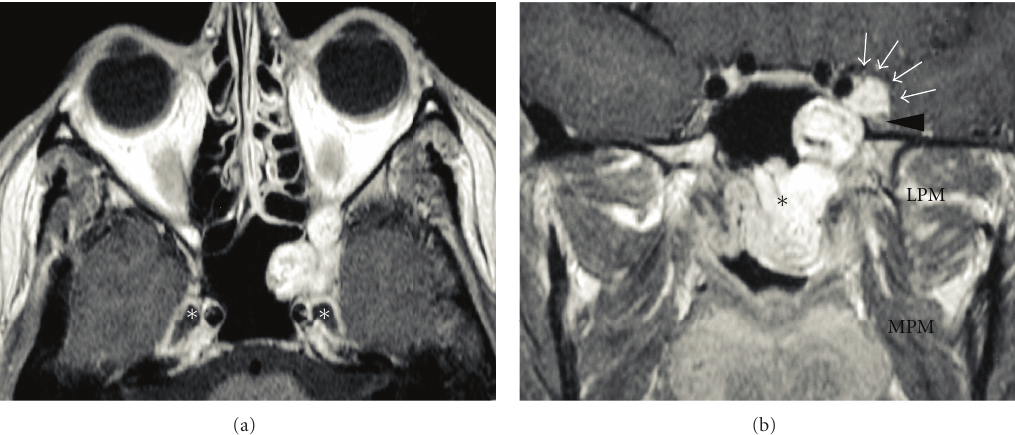
Figure 3: Axial (a) and coronal (b) contrast-enhanced MRI. JA with its epicenter into the root of the left pterygoid process. The nasopharyngeal component with submucosal spread is clearly evident (black asterisk). The lesion reaches the intracranial extradural compartment through the inferior and superior orbital fissures (white arrows), inferolaterally displacing the maxillary nerve (black arrowhead). The white asterisk indicates Meckel’s cave. LPM: lateral pterygoid muscle; MPM: medial pterygoid muscle.